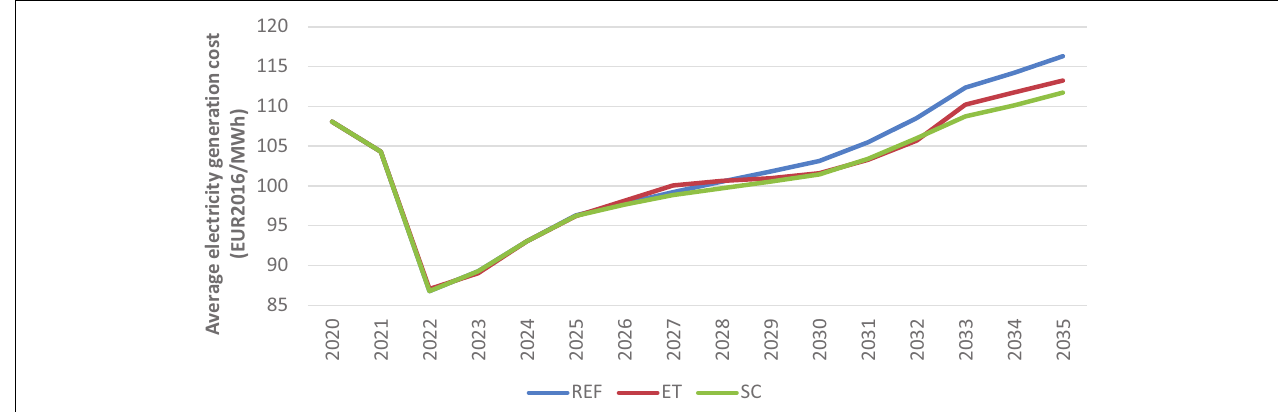
FIGURE 3 | Average electricity generation cost projection in the three scenarios. The electricity cost is the same across scenarios until 2025, as noticeable differences in the electrification of transport only occur after this point. Even though differences between the scenarios are marginal, the REF scenario illustrates the highest electricity cost, while the lowest is observed in the SC